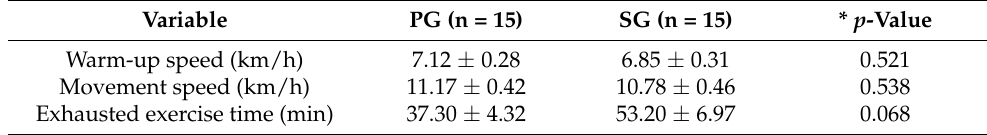
Table 2. Summary information of the constant load